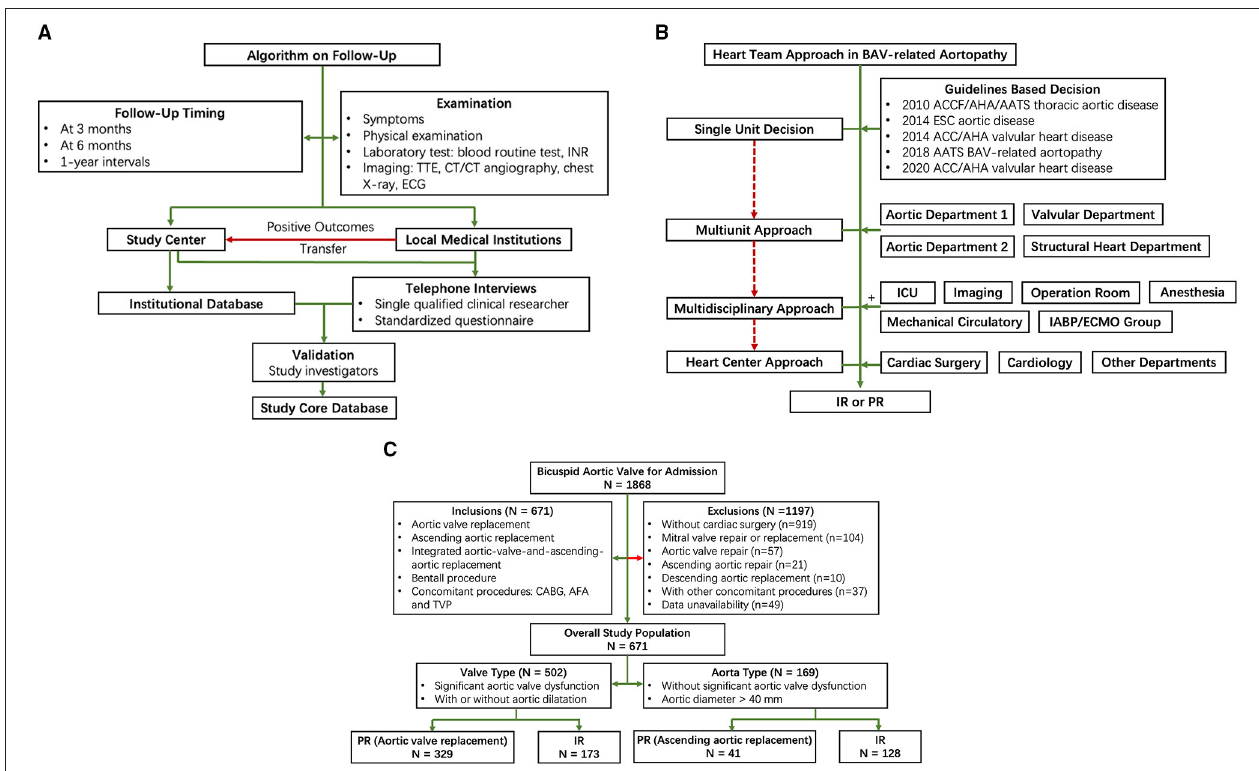
FIGURE 1 | Flow diagram of study design. (A) Follow-up; (B) Heart team approach; and (C) Patient selection. AFA, atrial fibrillation ablation; CABG, coronary artery bypass graft; ICU, intensive care unit; INR, international normalized ratio; IR, integrated aortic-valve-and-ascending-aortic replacement; PR, partial replacement; TTE, transthoracic echocardiography; TVP, tricuspid valve